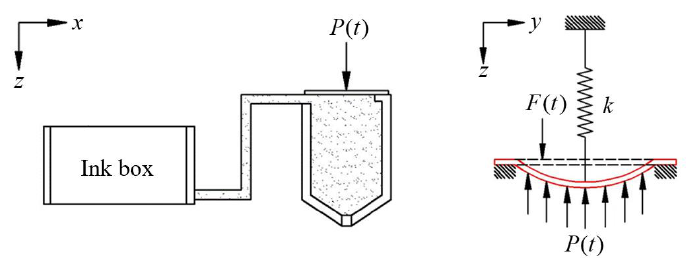
Figure 4. Simplified model of the droplet injection process. Substituting the above formula into Equation (2), the force equation of the PZT mem- brane can be obtained